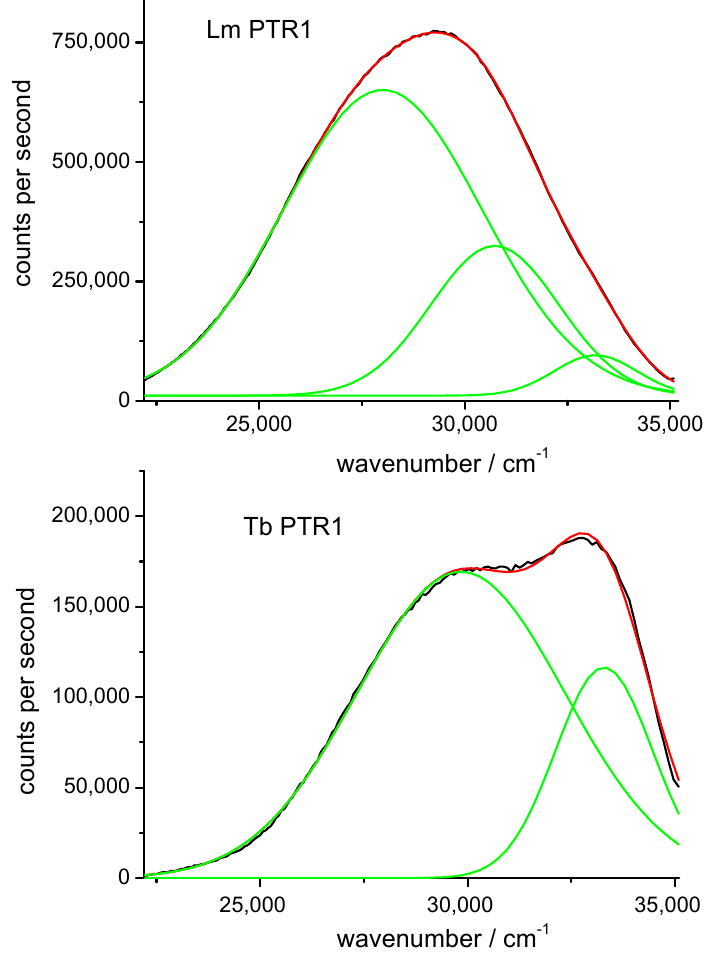
Figure 2. Fluorescence emission spectra of Lm and Tb PTR1 (black lines) and their representations (red lines) as sums of three Gaussian bands (green lines). Excitation at 280 nm. Table 1. Results of Gaussian band reconstructions of emission spectra of Lm and Tb PTR1: hmw = width at half maximum. Excitation at 280 nm.